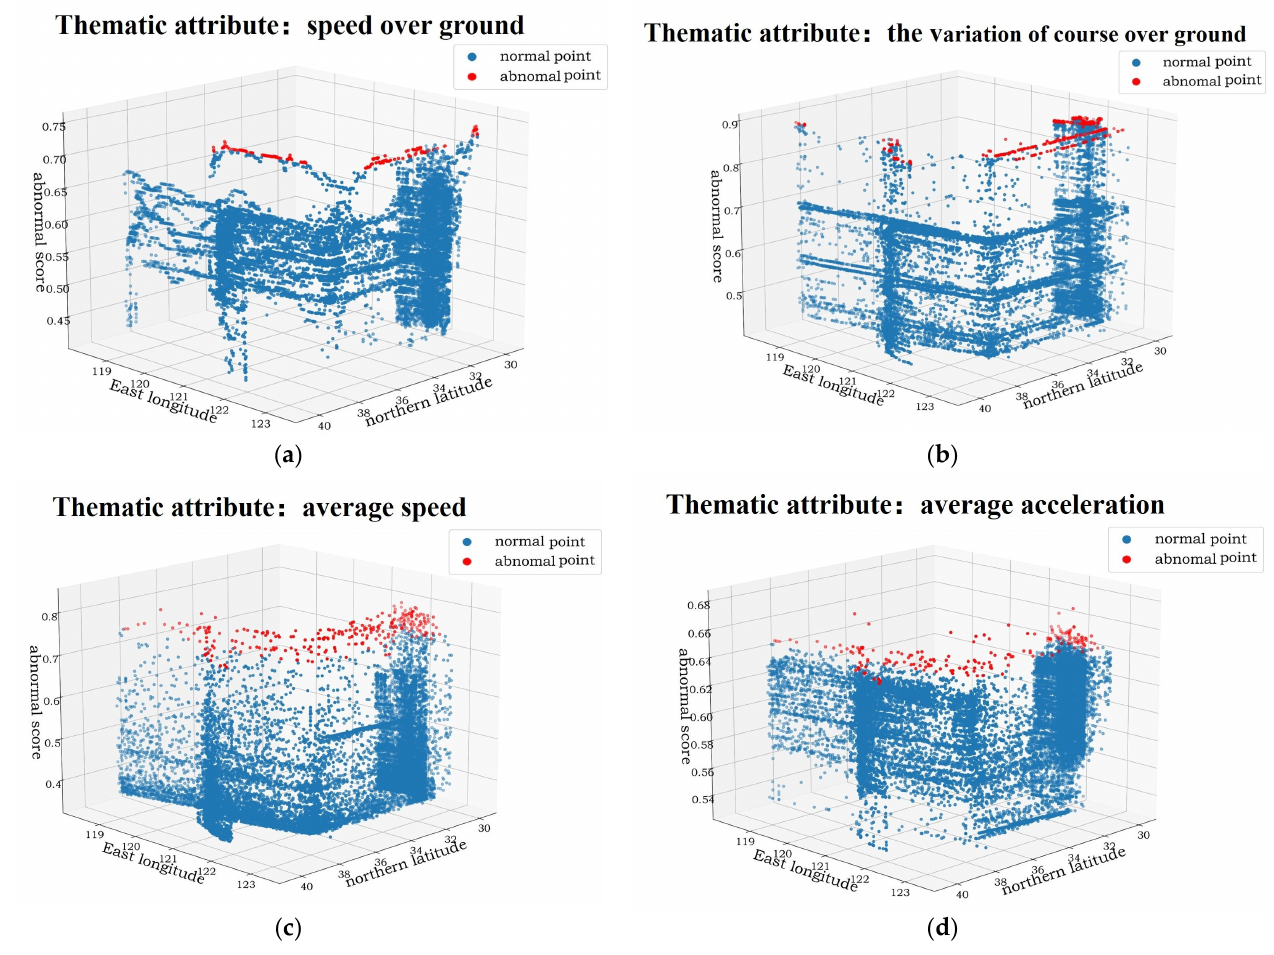
Figure 15. Spatial distribution of abnormal ship behavior detection scores based on thematic attributes. ( a ) The spatial distribution of the detection score for abnormal ship behavior with the thematic attribute of the instantaneous speed over ground. ( b ) The spatial distribution of the detection score for abnormal ship behavior with the thematic attribute as the variation of the course over ground. ( c ) The spatial distribution of the detection score for abnormal ship behavior with the thematic attribute as the average speed. ( d ) The spatial distribution of the detection score for abnormal ship behavior with the thematic attribute as the mean acceleration.